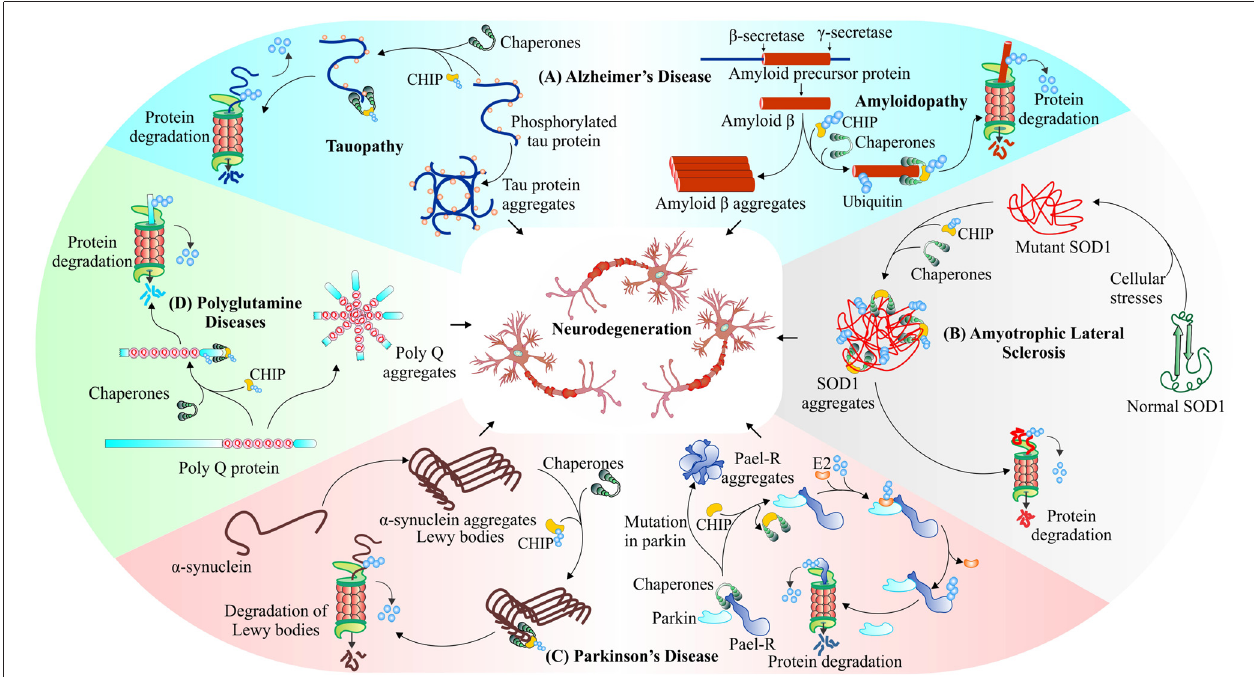
FIGURE 5 | CHIP, a major E3 ubiquitin ligase of neurodegenerative disorders. CHIP ameliorates proteotoxicities in various proteinopathies. Studies have shown that CHIP targets phosphorylated tau (Petrucelli et al., 2004; Qian et al., 2006; Koren et al., 2009), beta-amyloid (Kumar et al., 2012) in Alzheimer’s disease (A) , mutant superoxide dismutase (SOD1) aggregates (Urushitani et al., 2004) in Amyotrophic lateral sclerosis (ALS; B) , Parkin-Associated Endothelin Receptor-Like Receptor (Pael-R; Imai et al., 2002; McDonough and Patterson, 2003; Kumar et al., 2012), alpha-synuclein (Shin et al., 2005) in Parkinson’s disease (C) and polyglutamine protein aggregates (Jana et al., 2005; Williams et al., 2009) in polyglutamine diseases (D) , for their proteasomal